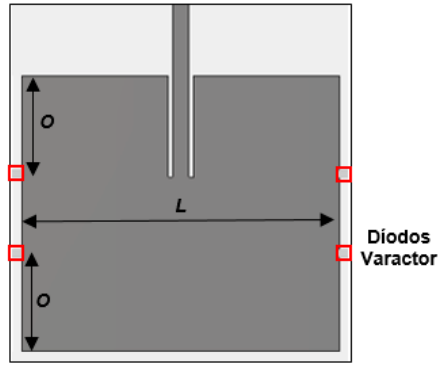
Figure 8. Representation of variables O and L in the patch.